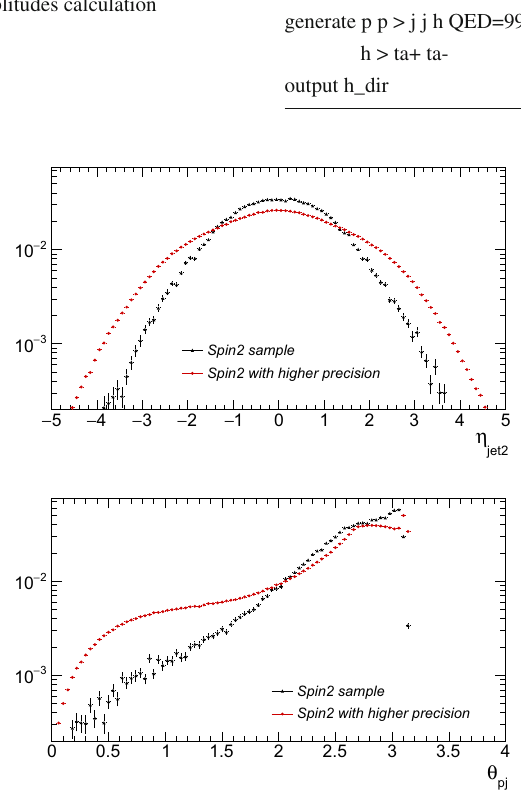
Fig. 7 Histograms of η jet 2 and θ pj distributions, normalised to unity, from MadGraph generated X samples. Black points are for the default 8 iterations used at initialisation, and red (grey) points for 99